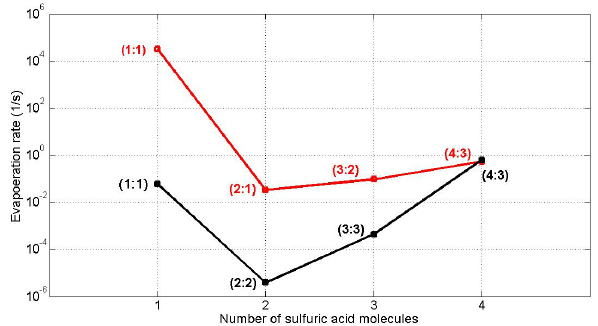
Fig. 5. Evaporation rates for the most stable clusters independently of the number of bases in it including non-monomer evaporation, composition of each cluster is indicated in parenthesis (acid:base), black line correspond to DMA containing clusters and red line to ammonia containing clusters.